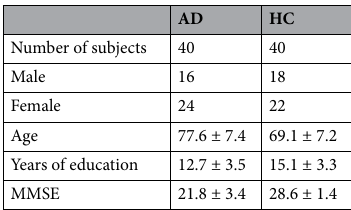
Table 3. Subject information of the NTUHV dataset (AD vs.